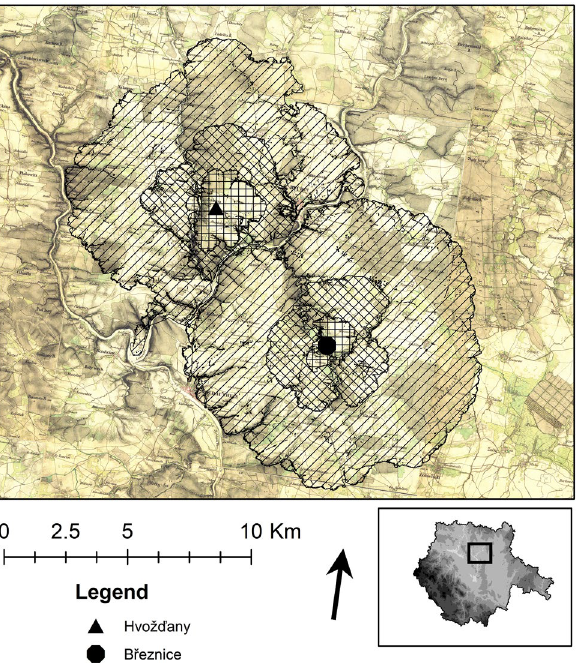
Figure 7. Březnice and Hvožďany: the map of the second military mapping. Site catchements 81 are according to the walk distance 83 are shown